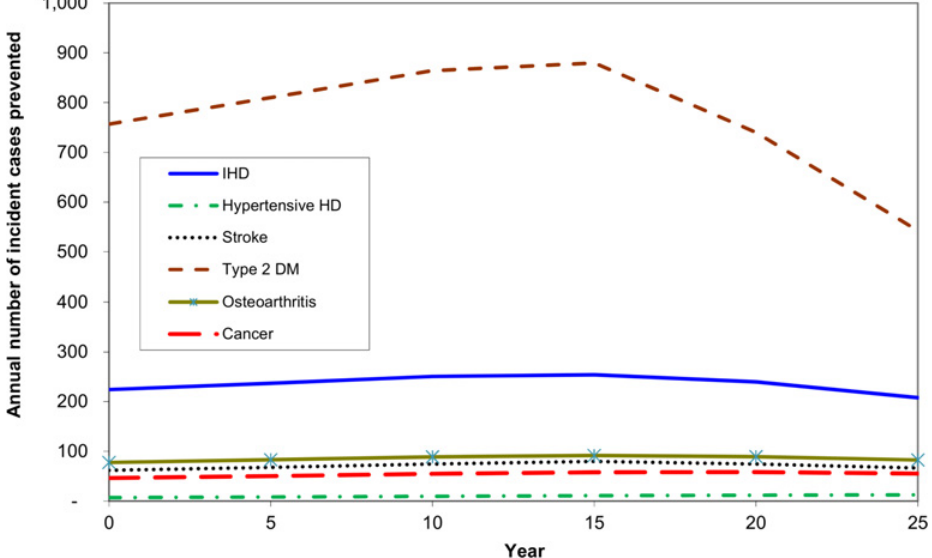
Fig 2. Projected annual number of new cases of disease prevented over time after implementation of a 20% tax on sugar sweetened drinks in Australia.